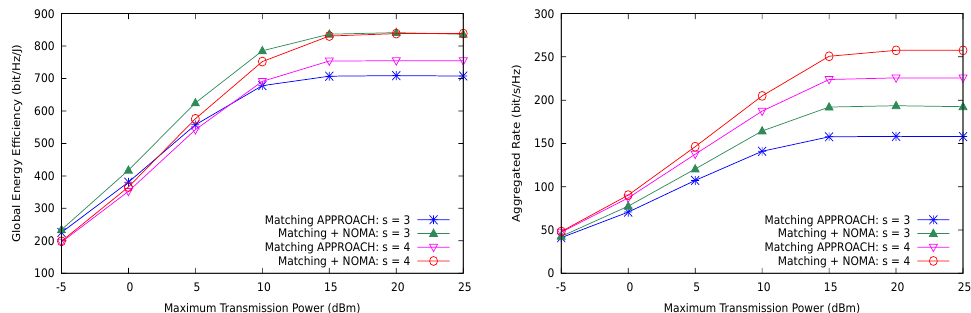
Figure 8. Global energy efficiency and aggregated rate with the matching theory based solution vs. NOMA for the general